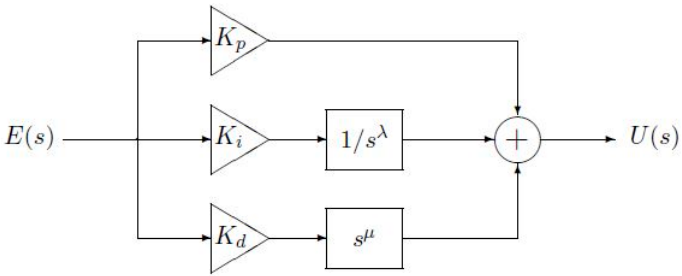
Figure 2. FOPID controller structure.